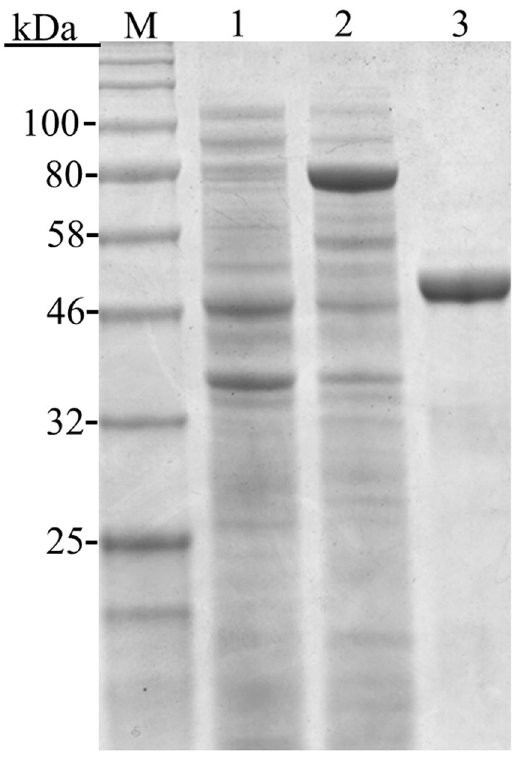
Figure 3. The 12% SDS-PAGE analysis of MgPDI expressed in E . coli BL21 (DE3). The total proteins (lane 1), the expressed product of pET-32a-MgPDI induced by IPTG (lane 2) and enriched nontagged MgPDI (lane 3) were run on one